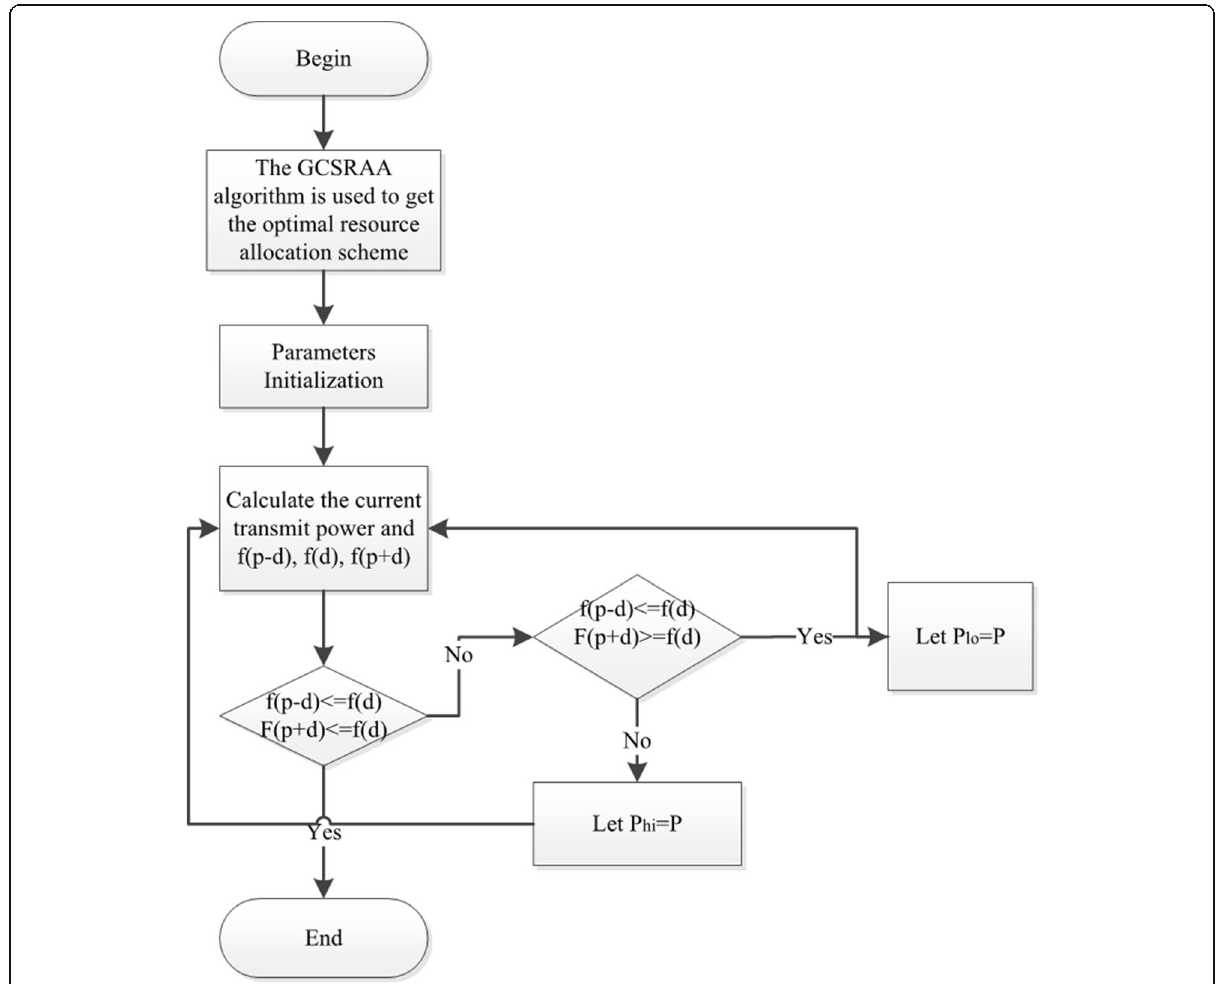
Fig. 1 Energy efficiency optimization algorithm for carrier aggregation